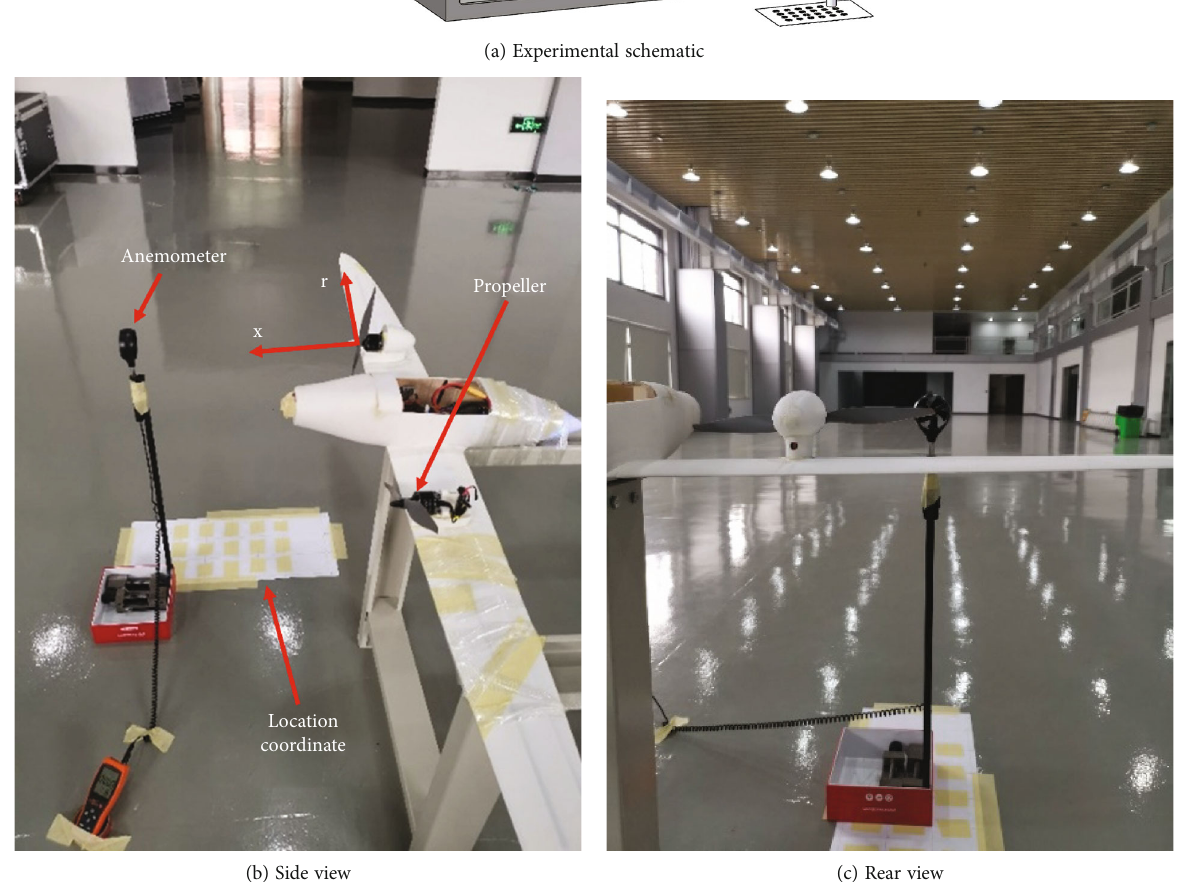
Figure 6: The propeller slip- fl ow speed testing